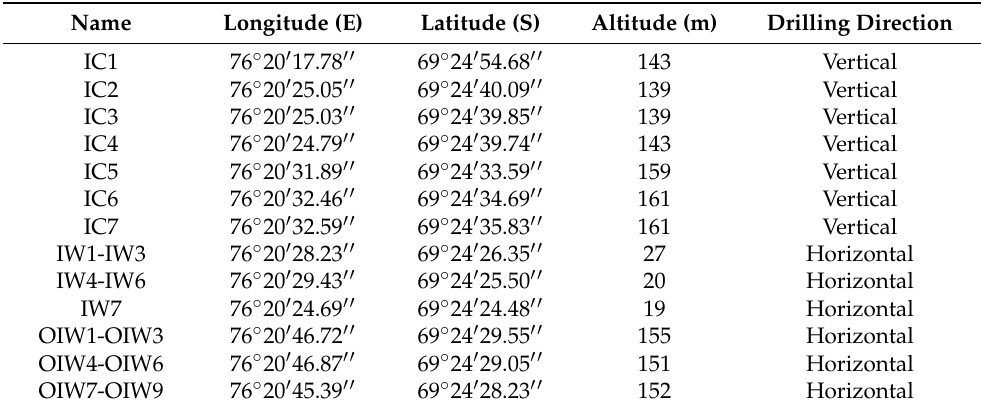
Figure 1. Maps of the drilling sites. ( a ) Map of Antarctica; ( b ) map of Dalk Glacier region; ( c ) map of the drill sites of the ice cores (the blue arrow represents the direction of ice flow); ( d ) drill sites of IW ice cores; ( e ) drill sites of OIW ice cores; ( f ) IW1-IW3; ( g ) IW4-IW6; ( h ) IW7; ( i ) OIW1-OIW3; ( j ) OIW4-OIW6; ( k ) OIW7-OIW9. Table 1. Basic information of sampling sites.